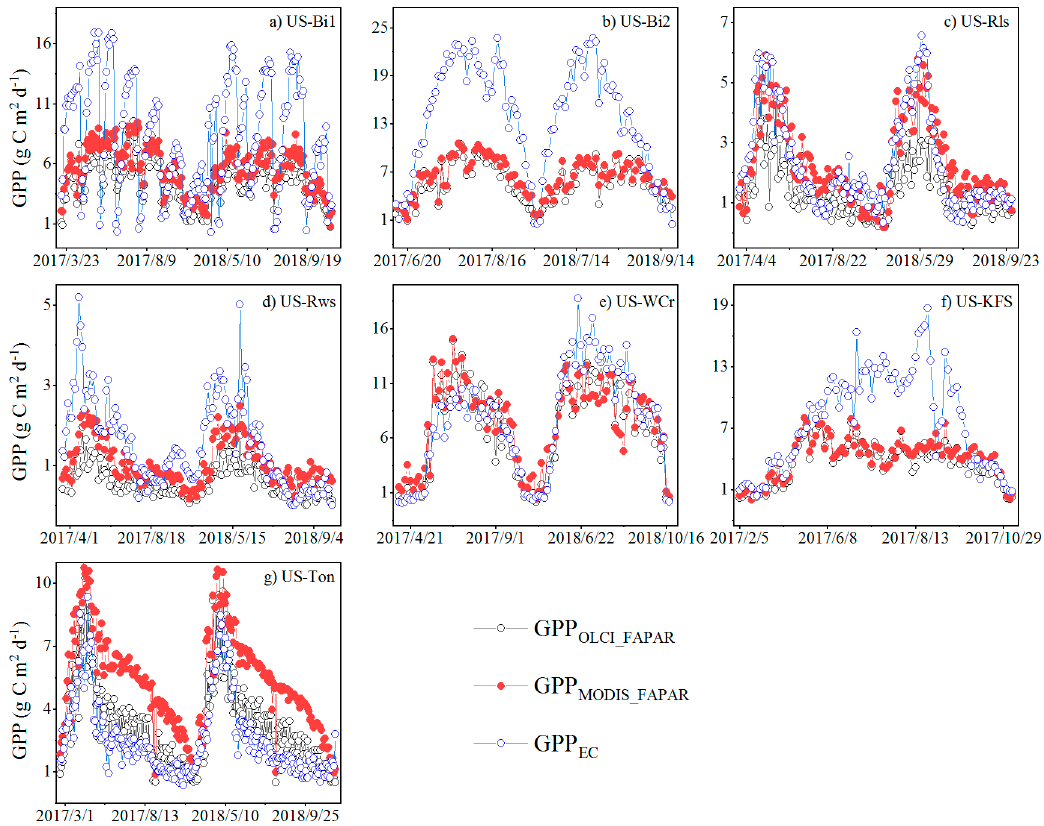
Figure 9. Temporal dynamics of GPP MODIS-FAPAR (GPP with the FAPARfrom the Moderate Resolution Imaging Spectroradiometer (MODIS)), GPP OLCI-FAPAR , and GPP EC for all sites in 2017 and 2018. ( a – g ) represent the sites the same as Figure 2.